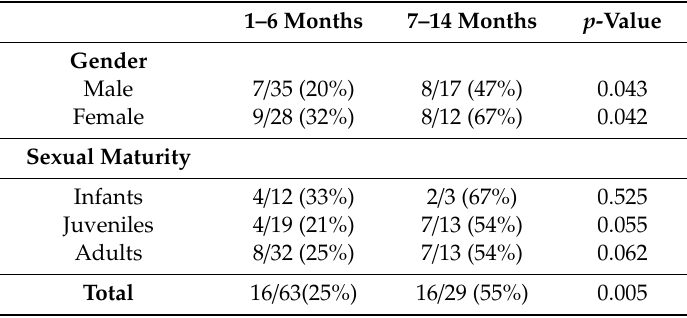
Table 2. Comparison of SFV prevalence in relation to sex and sexual maturity of groups classified according to captivity time at Centro de Primatologia do Rio de Janeiro